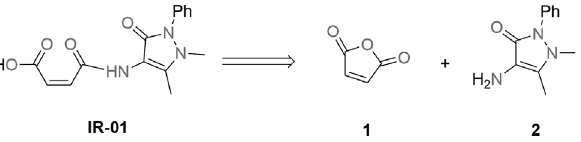
Figure 1 - Retrosynthetic analysis for ( Z )-4-((1,5-dimethyl-3-oxo-2-phe- nyl-2,3dihydro-1 H -pyrazol-4-yl) amino)-4-oxobut-2-enoic acid.